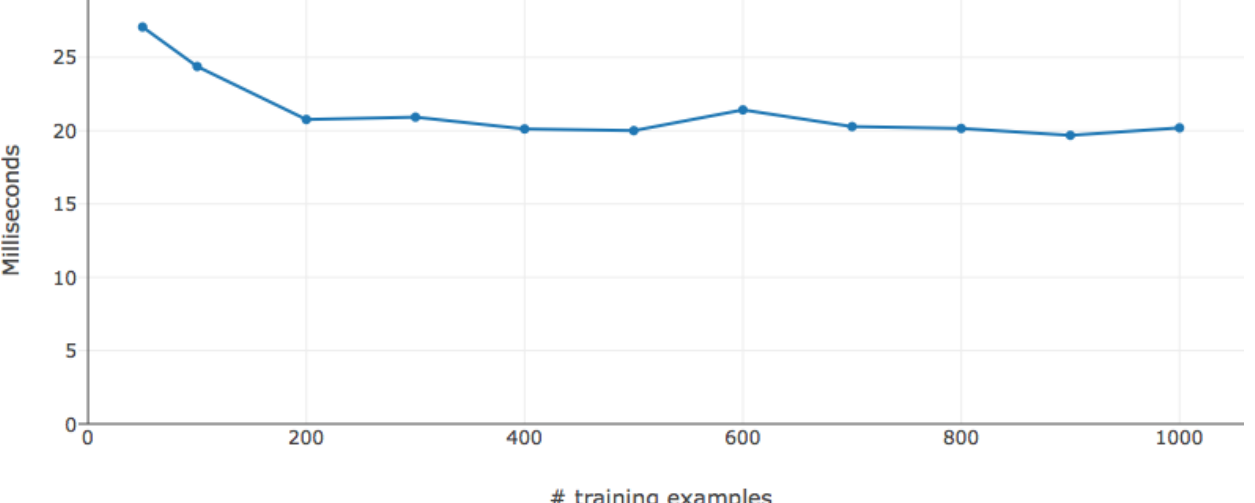
Figure 12. Time for suffix array extraction per DOM